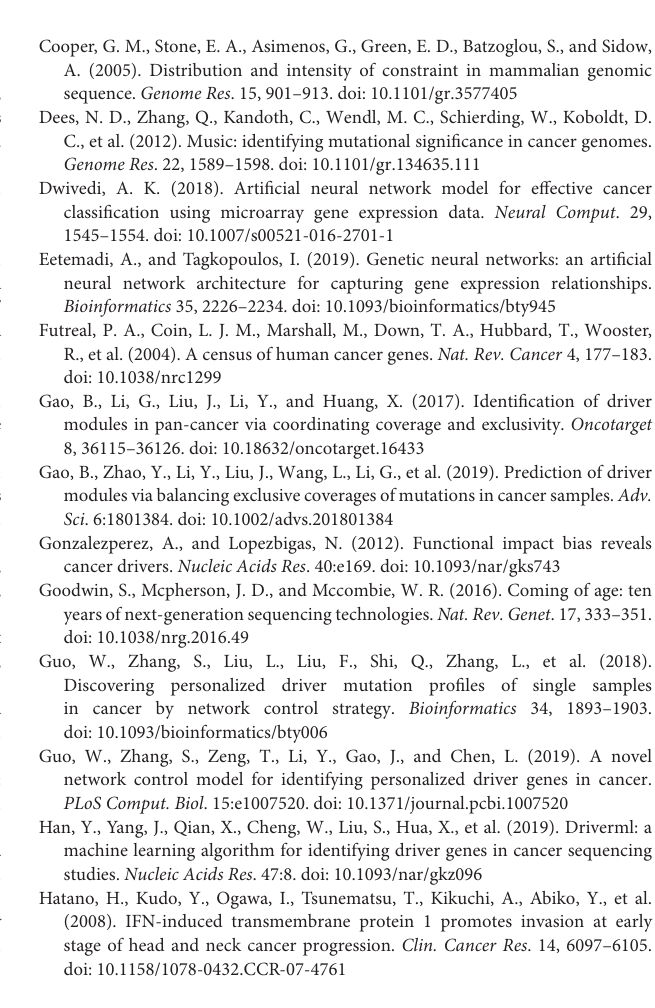
Supplementary Table 1 | The driver genes predicted by